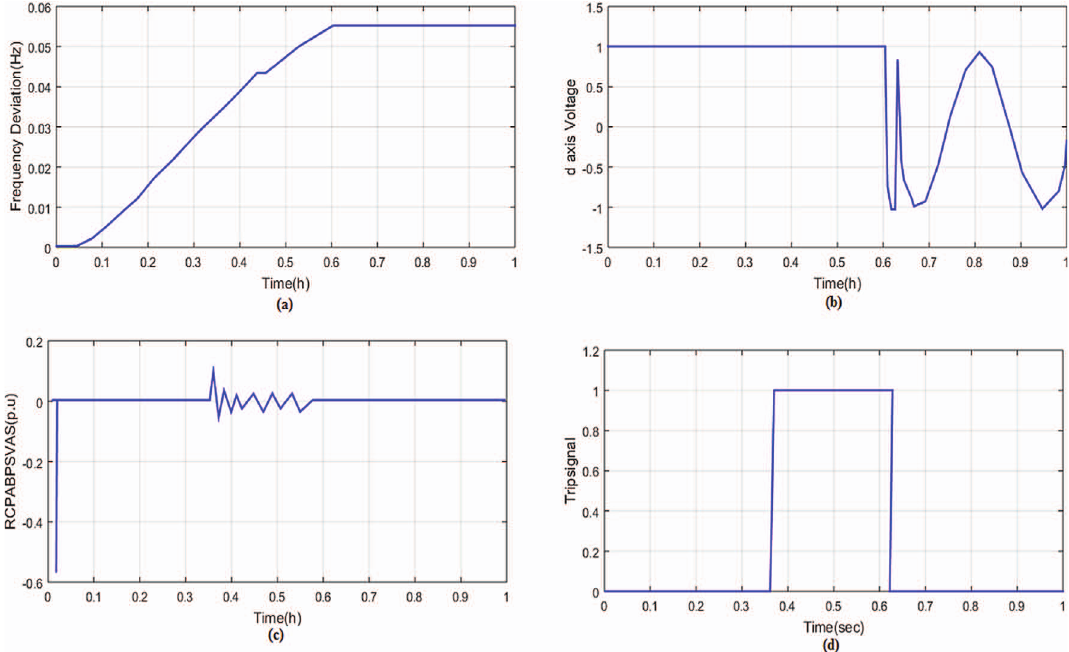
Fig. 7. System performance under normal loading conditions, (a) frequency deviation versus time, (b) d -axis voltage versus time, (c) RCPABPSVAS versus time, and (d) trip signal versus